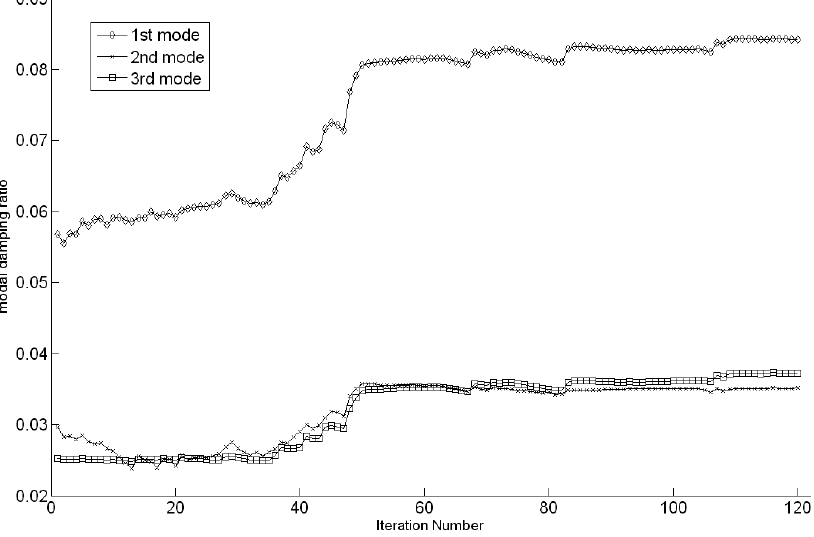
Fig. 24. Iteration histories for different modes vf = 0.6.